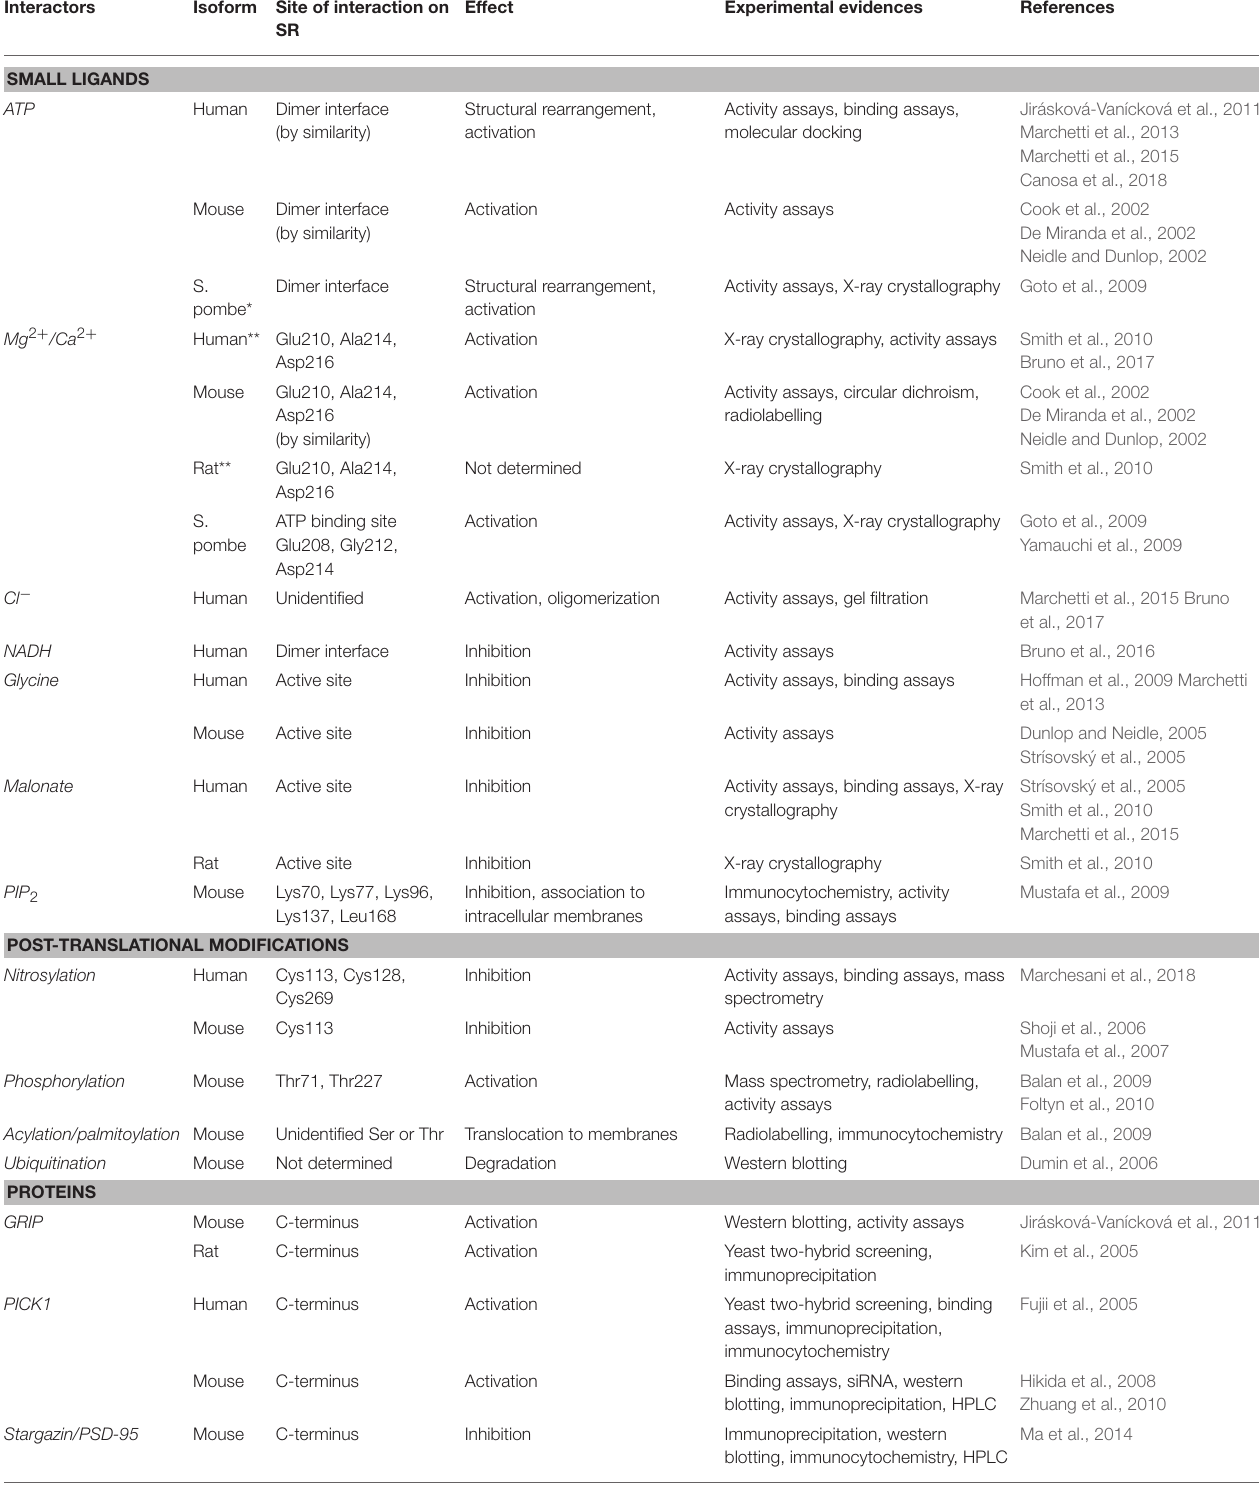
TABLE 4 | SR interactors and effects on SR structure and